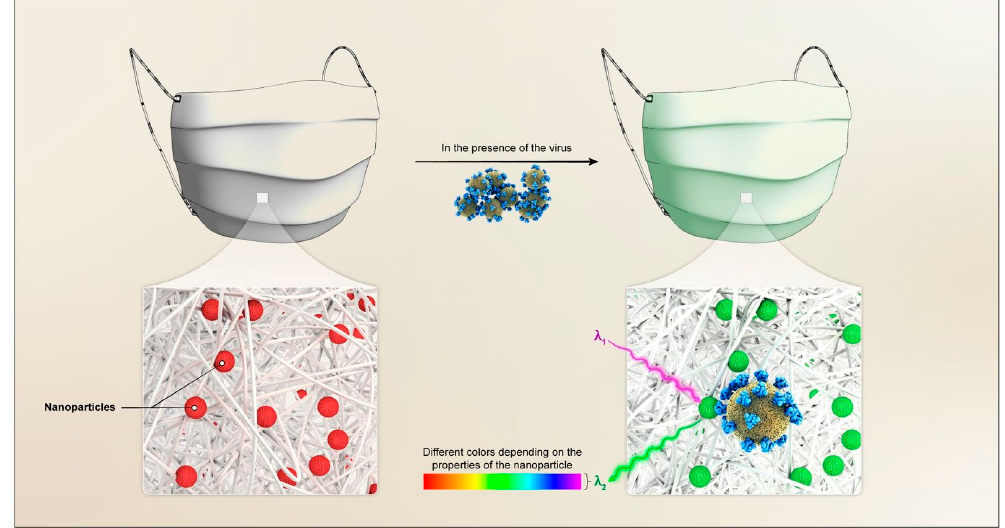
Figure 6. Schematic illustration of SERS intensity and color changes of mask-embedded nanoparticles (NPs) in the present of SARS-CoV-2.